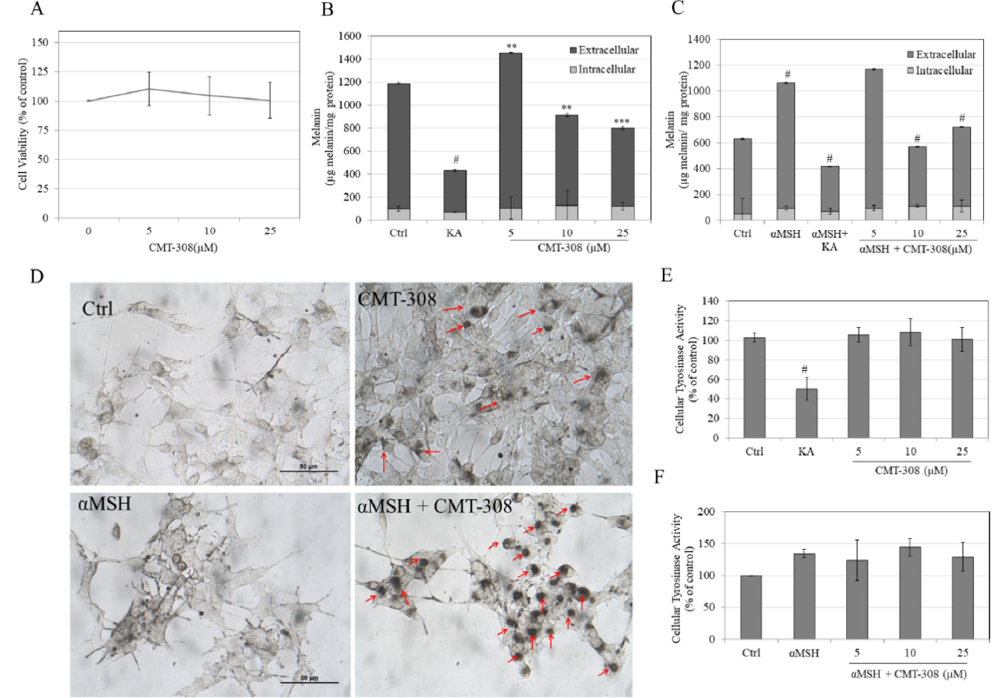
Figure 3. ( A ) Viability of B16F10 cells exposed to different concentrations of CMT-308 over 72 h assessed by MTS assay; total melanin levels in the cultures were quantified and were expressed as ( C ) melanocyte-stimulating hormone ( α -MSH)-stimulated melanogenesis; KA was used as a